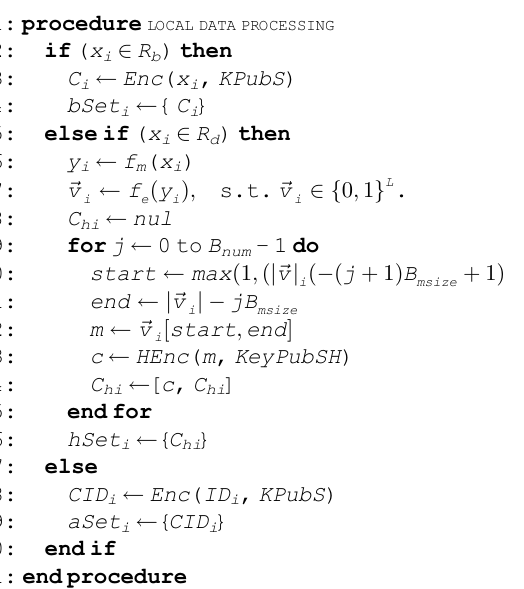
Algorithm 1 Operations on Client (Part